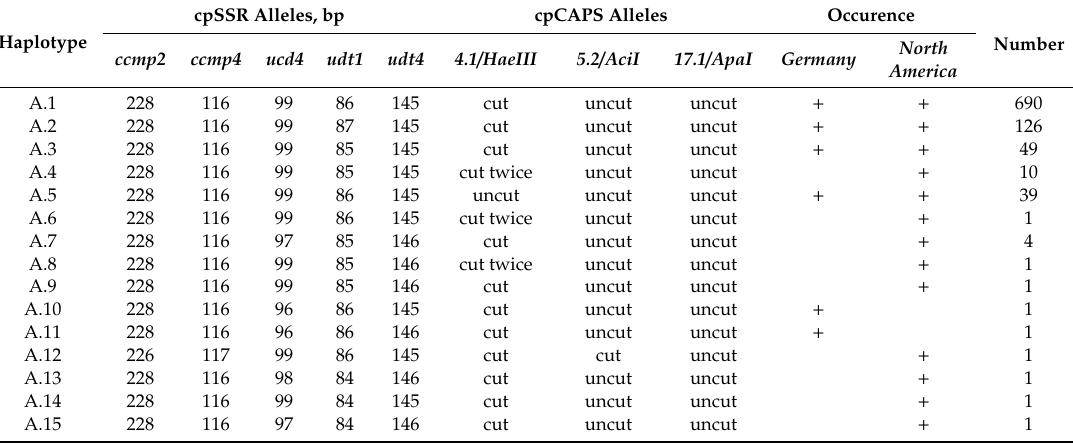
amplified polymorphic sequences (cpCACPS), and occurrence of Q. rubra chloroplast